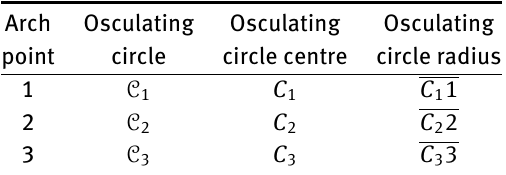
Table 1: Osculating circles, centres and radii for the parabolic arch of Fig.